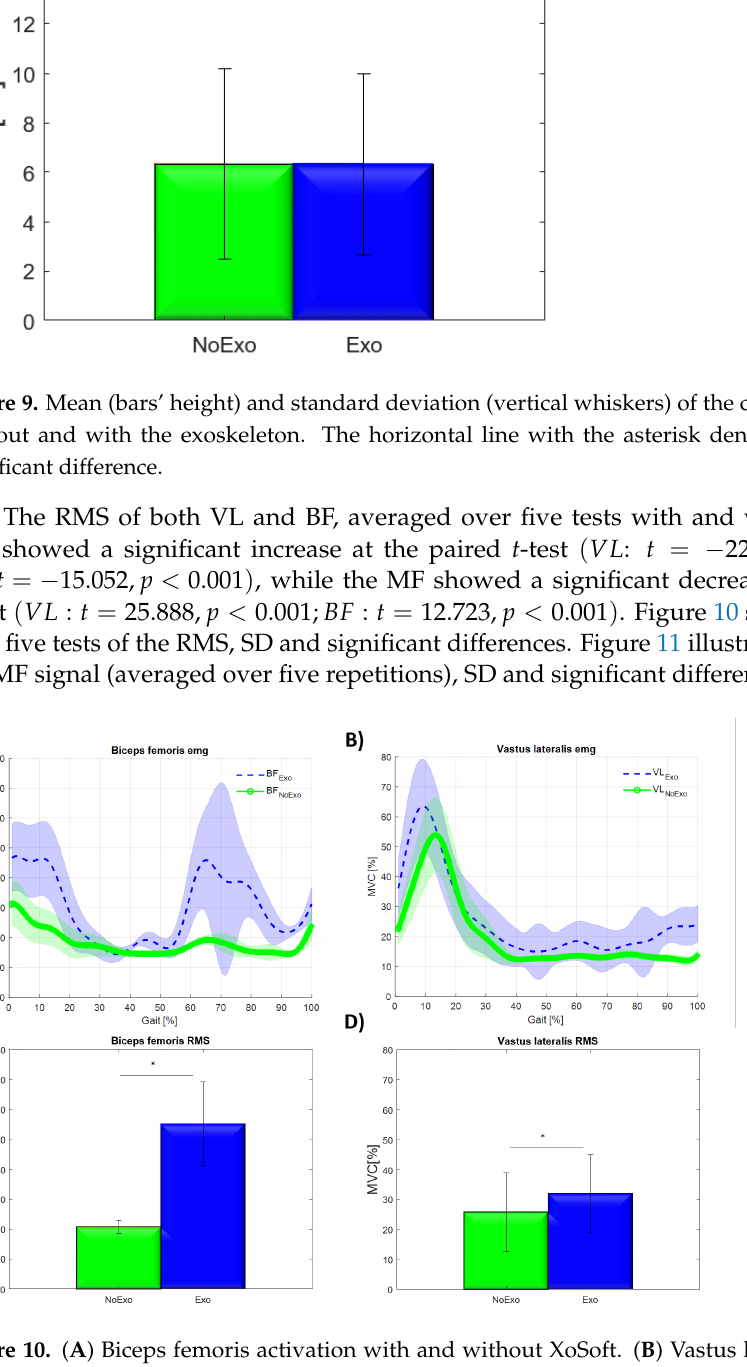
Figure 10. ( A ) Biceps femoris activation with and without XoSoft. ( B ) Vastus lateralis activation with and without XoSoft. ( C ) Biceps femoris RMS mean (bars’ height), standard deviation (vertical whiskers) with and without the exoskeleton. ( D ) Vastus lateralis RMS mean (bars’ height), standard deviation (vertical whiskers) with and without the exoskeleton. Both in panels ( C , D ), the horizontal line with the asterisk denotes a statistically significant